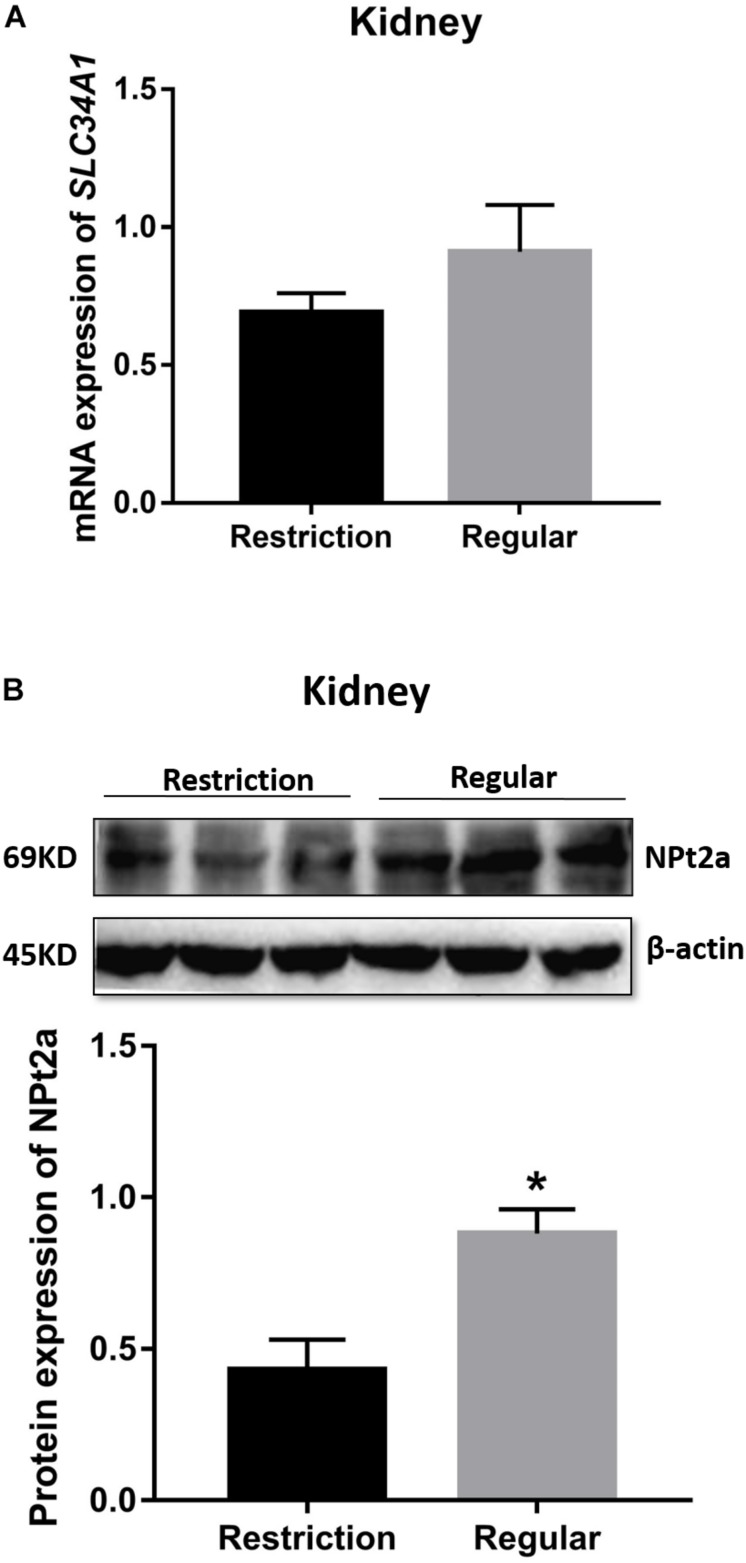
Effects of dietary non-phytate phosphorus levels (restriction, 0.14%; regular, 0.32%) on kidney expressions SLC34A1 mRNA (A) and NPt2a protein (B) in laying hens. SLC34A1 is the gene coding for type 2a sodium-phosphorus co-transporter (NPt2a). Values are of 3 hens/treatment. *P < 0.05. Experiment 2.